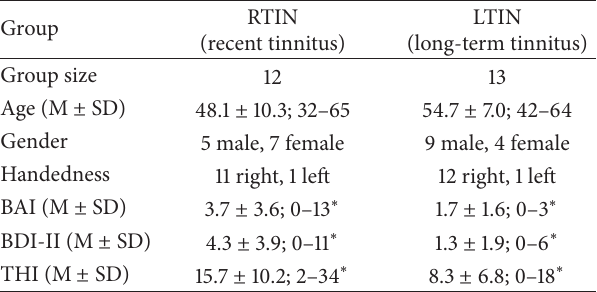
Table 1: Demographic and clinical characteristics for both groups. THI: tinnitus handicap inventory; BAI: Beck anxiety inventory; BDI-II: Beck depression inventory. Age, THI, BAI, and BDI-II scores were compared using independent sample 𝑡 -tests. ∗ indicates significant difference between groups at 𝑝 < 0.05